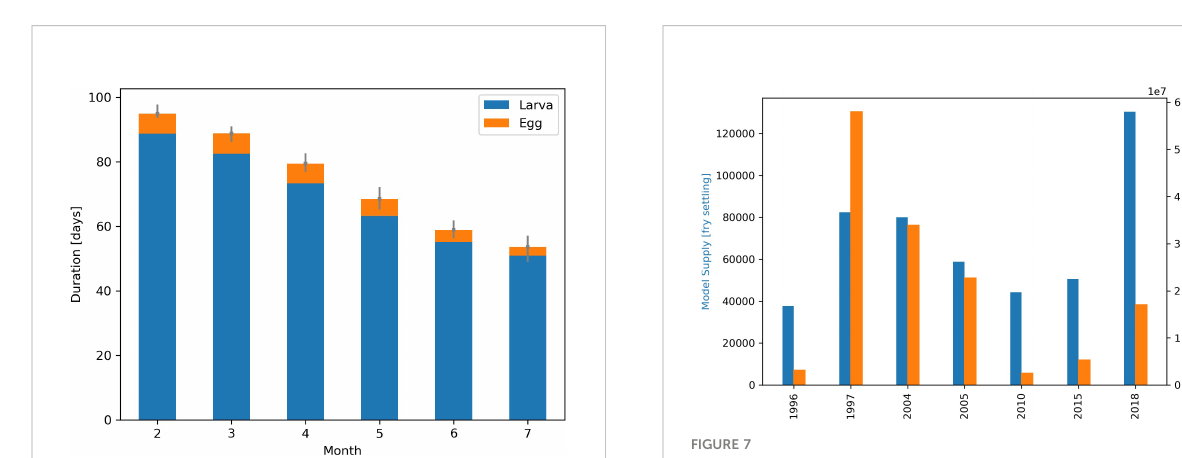
FIGURE 7 Comparison between model supply to coastal nursery ground (blue; number of fry settling) with ICES recruitment index (orange), for each year of analysis.